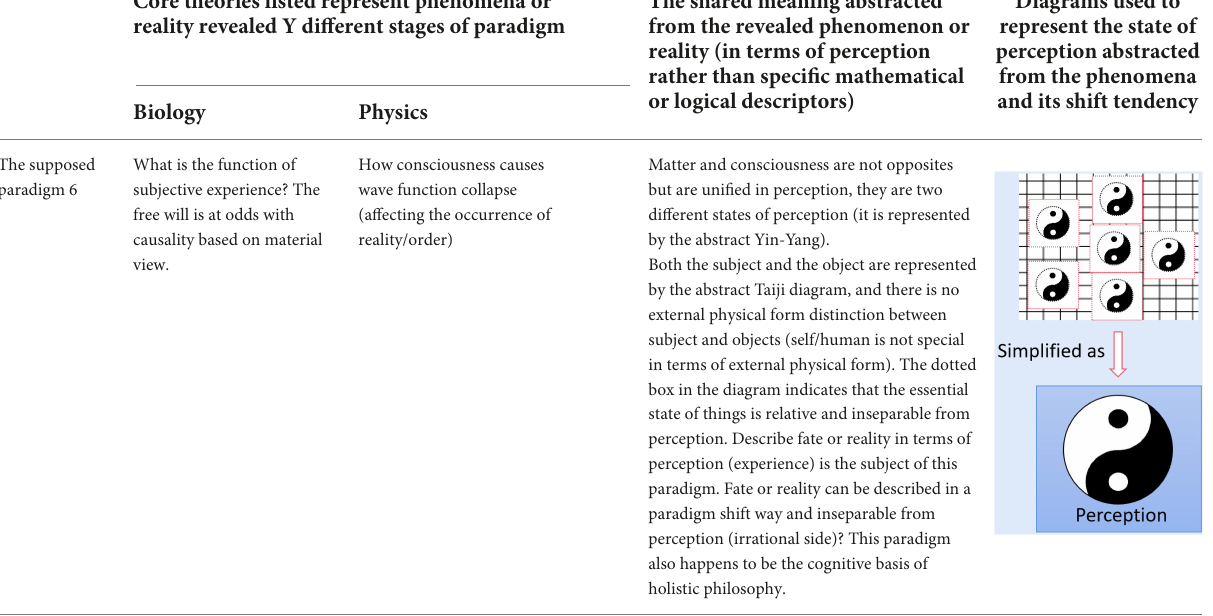
TABLE 2 Describing the evolution of reality in terms of perceived abstract contradictions (Yin-Yang) may be the next paradigm reconciling the antagonistic relationship between matter and consciousness. Core theories listed represent phenomena or The shared meaning abstracted reality revealed Y different stages of paradigm from the revealed phenomenon